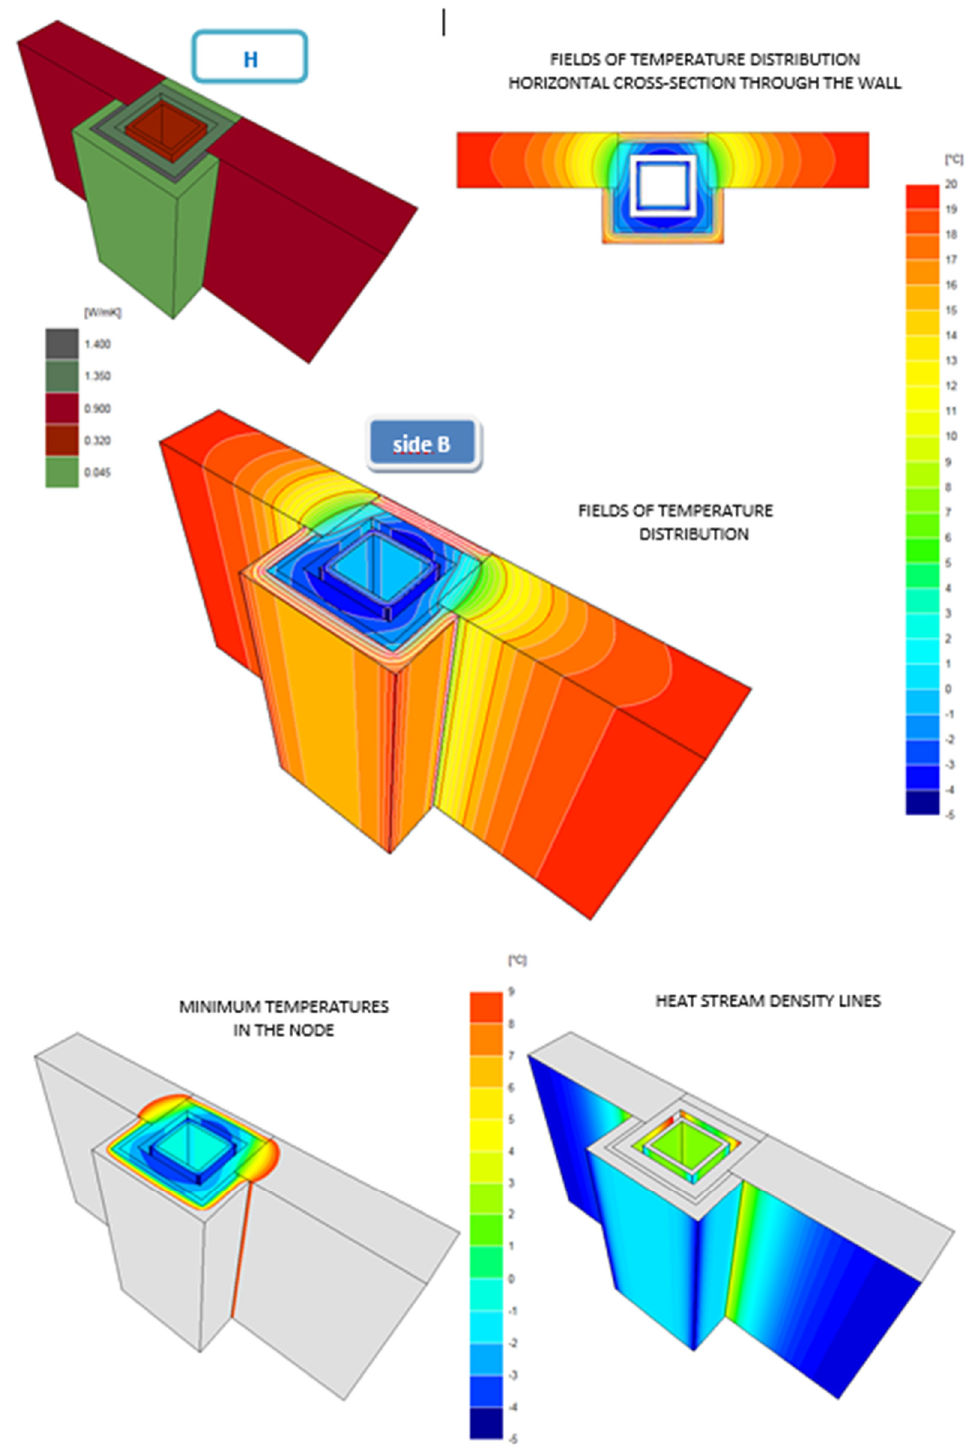
Figure A7. Scheme H: distribution of isotherm field, minimum surface temperature, and heat flux distribution.